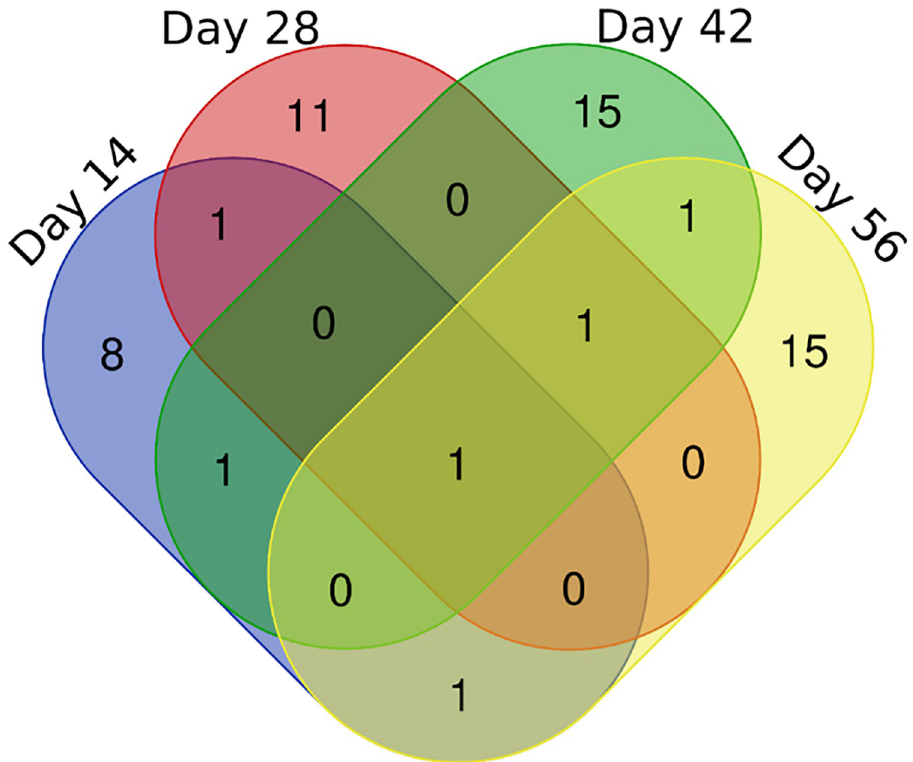
Fig 7. Circulating antigens of S . mekongi identified in infected mouse sera at 14-, 28-, 42-, and 56-days post- infection using mass spectrometric analysis. Numbers represent number of S . mekongi circulating antigens identified by mass